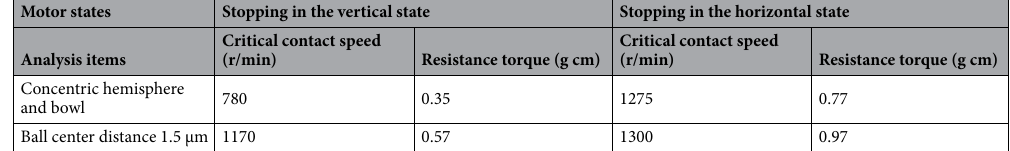
Table 5. Critical contact speed and resistance torque of motor under different